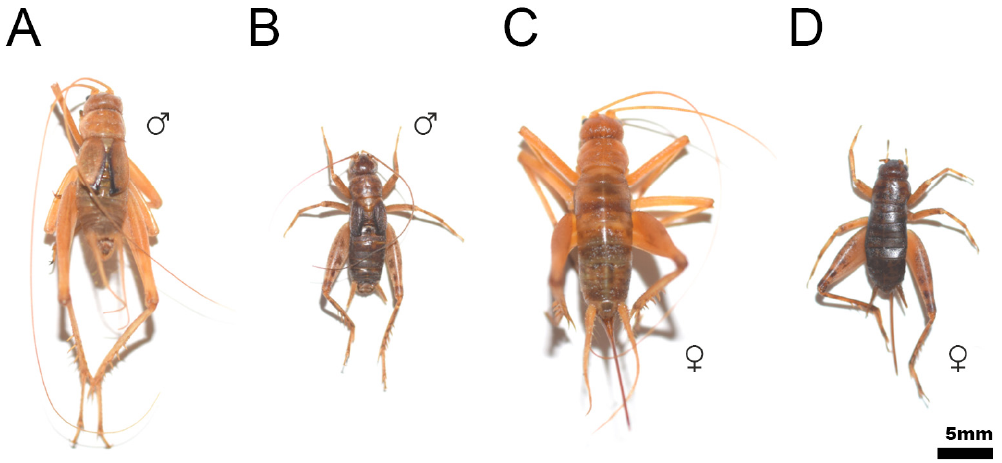
Figure 13. Coloration of the type species of the subgenera Zapetaloptila (( A , C ), male and female of P. barrancoi ) and Petaloptila (( B , D ), male and female of P. aliena ). Specimens were preserved in 70% alcohol of the orthoptera collection of the Entomology Laboratory of the Biology and Geology Department of the University of Almería. ( A ) P. barrancoi , Sima del Aire (Sierra de Gádor, Almería, Spain), 27/08/2013; ( C ) P. barrancoi Sima Puntal (Sierra de Gádor, Almería, Spain), 27/08/2013; ( B , D ) P. aliena Serrella (Sierra Serrella, Alicante, Spain), 10/2012. In all cases: P. Barranco coll. and det.